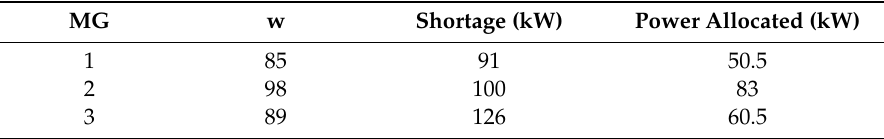
Figure 9. Results for optimal power allocation (case 1). Table 4. Initial shortage in microgrids and optimal power allocation for case 1.